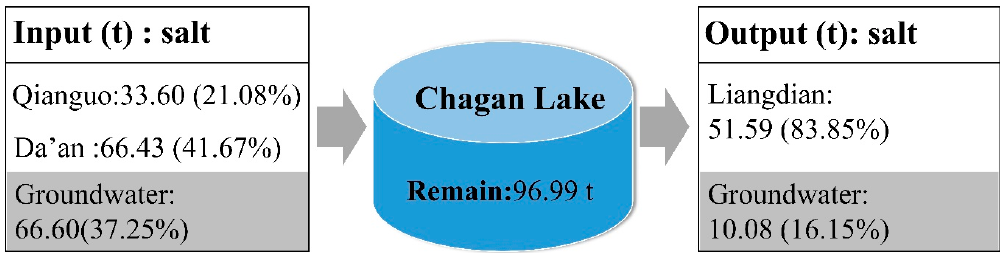
Figure 8. The overall mass balance for salt accumulation in Chagan Lake from May to October 2018.